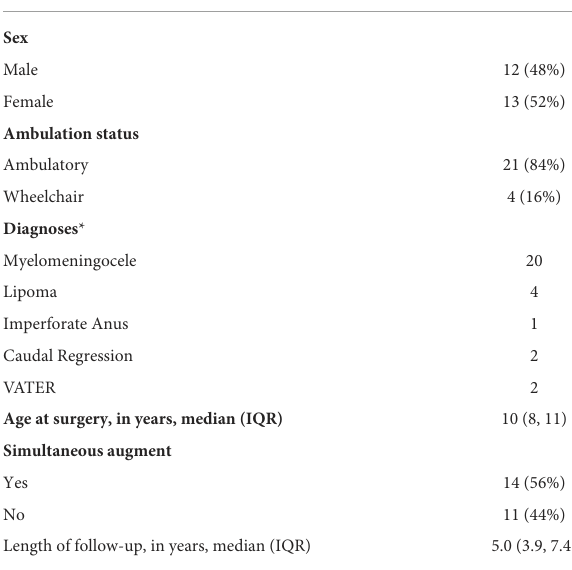
TABLE 1 Baseline